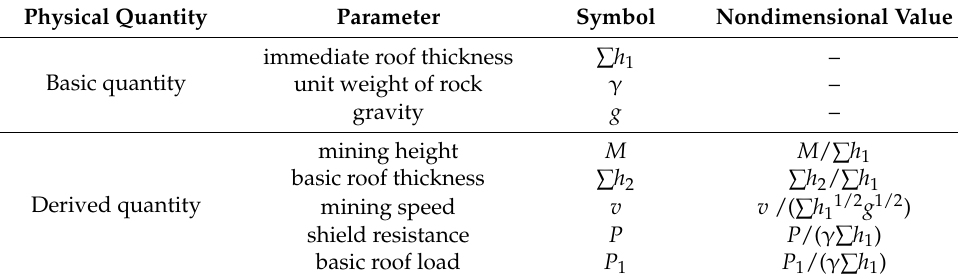
Table 3. Non-dimensional results of each derived